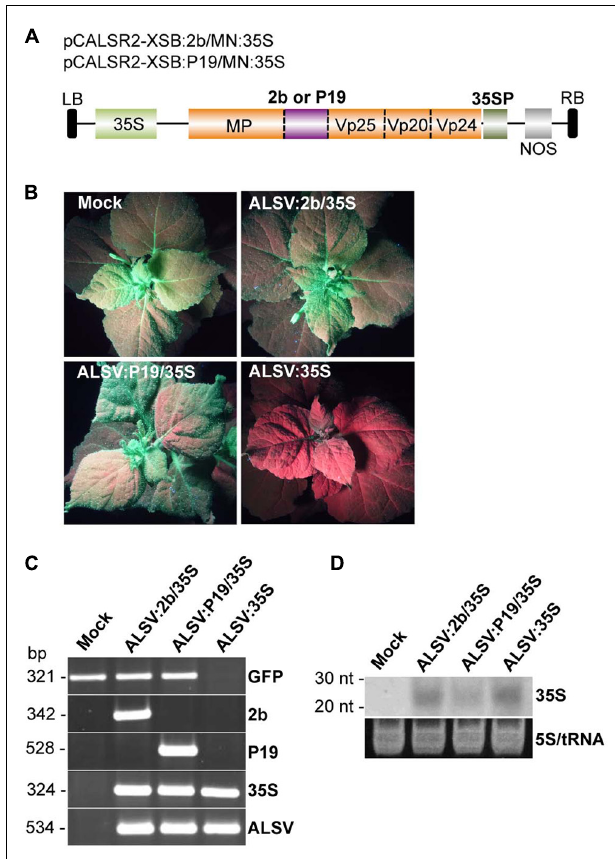
FIGURE 4 | Induction ofTGS byALSV vectors carrying an RNA silencing suppressor. (A) Schematic representation of ALSV vectors expressing a plant virus suppressor (2b or P19; pCALSR2-XSB:2b/MN:35S or pCALSR2-XSB:P19/MN:35S). (B) N. benthamiana line 16c plants expressing GFP and mock-agroinoculated (Mock), agroinoculated with pCALSR1 + pCALSR2-XSB:2b/MN:35S (ALSV:2b/35S), pCALSR1 + pCALSR2-XSB:P19/MN:35S (ALSV:P19/35S), or pCALSR1 + pCALSR2-XSB/MN:35S (ALSV:35S). Plants were photographed under UV illumination with a yellow filter.The red fluorescence reveals thatTGS of GFP occurred in ALSV:35S infected tissues. (C) Analysis of mRNAs in agroinoculated N. benthamiana line 16c plants by RT-PCR.Total plant RNA was extracted from plants agroinoculated with empty vector (Mock), ALSV:2b/35S, ALSV:P19/35S, or ALSV:35S. (D) Northern blot analysis of siRNAs corresponding to the CaMV 35S promoter gene.Total RNA was extracted from plants agroinoculated with empty vector (Mock), ALSV:2b/35S, ALSV:P19/35S or ALSV:35S, and hybridized with a sense DIG-labeled RNA probe of the CaMV 35S promoter.The 5S rRNA and tRNA were stained by ethidium bromide and are shown as a loading